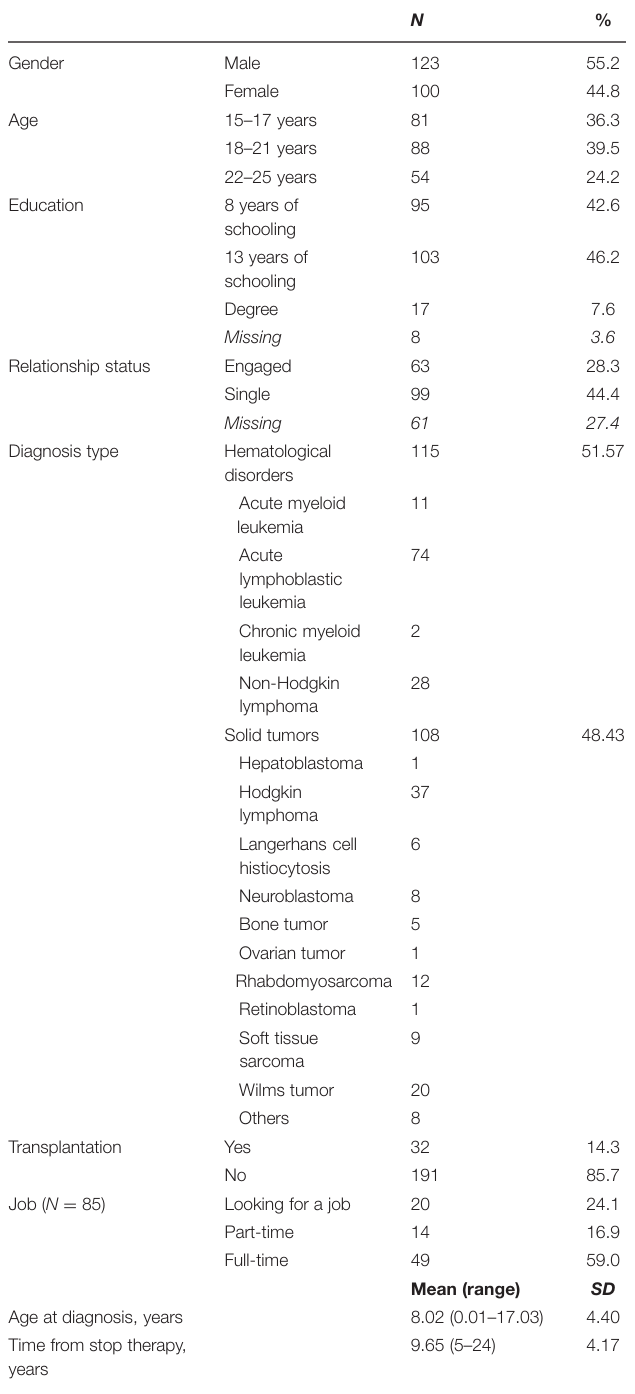
TABLE 1 | Socio-demographic and clinical characteristics of the